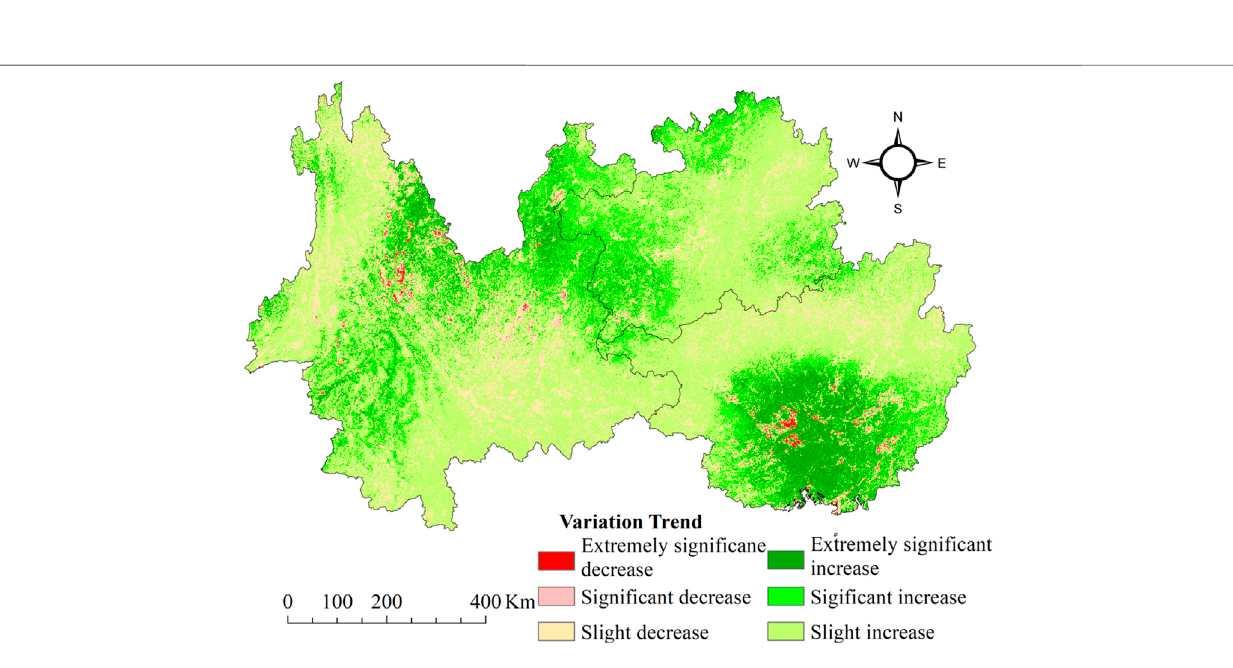
Frontiers in Earth Science |